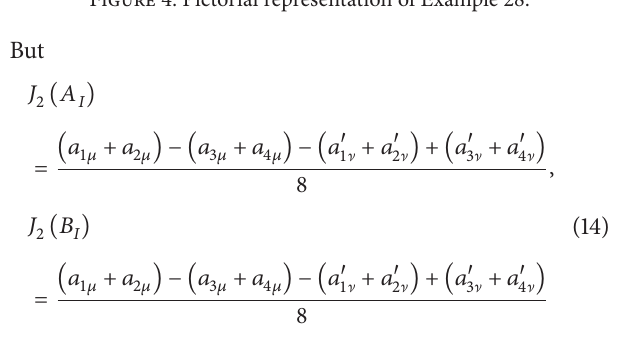
Figure 4: Pictorial representation of Example